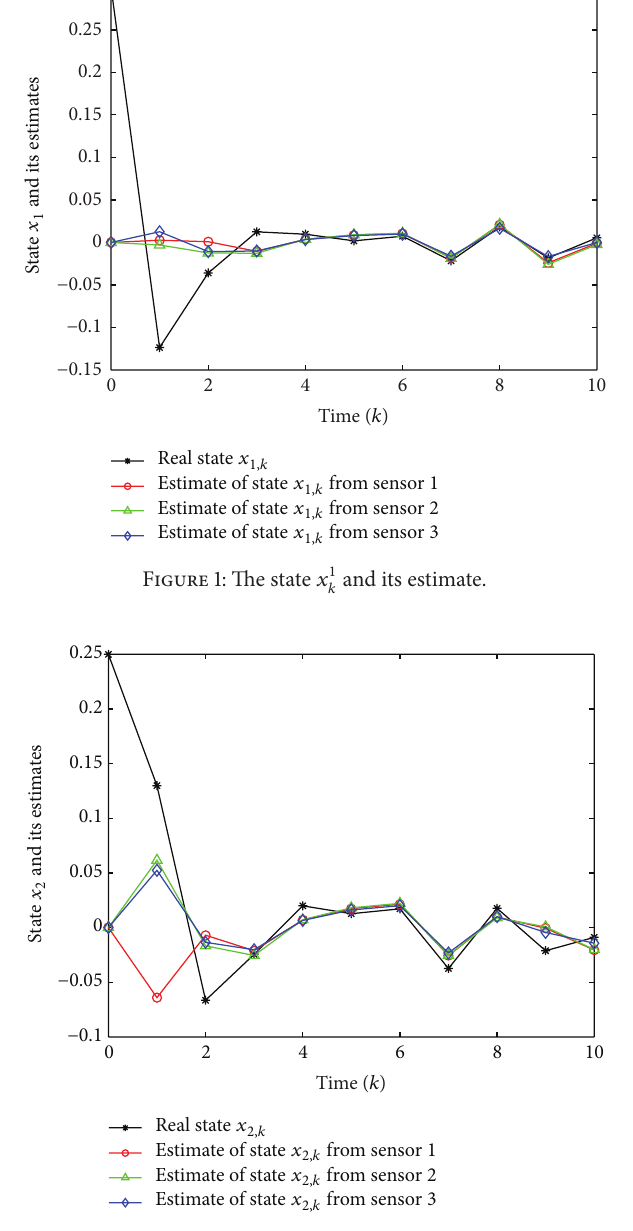
Figure 2: The state 𝑥 2 𝑘 and its